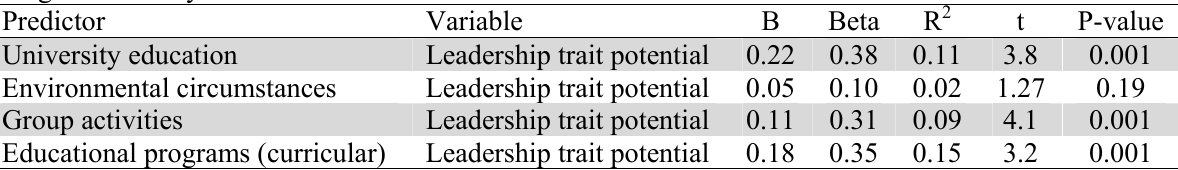
Regression analysis between